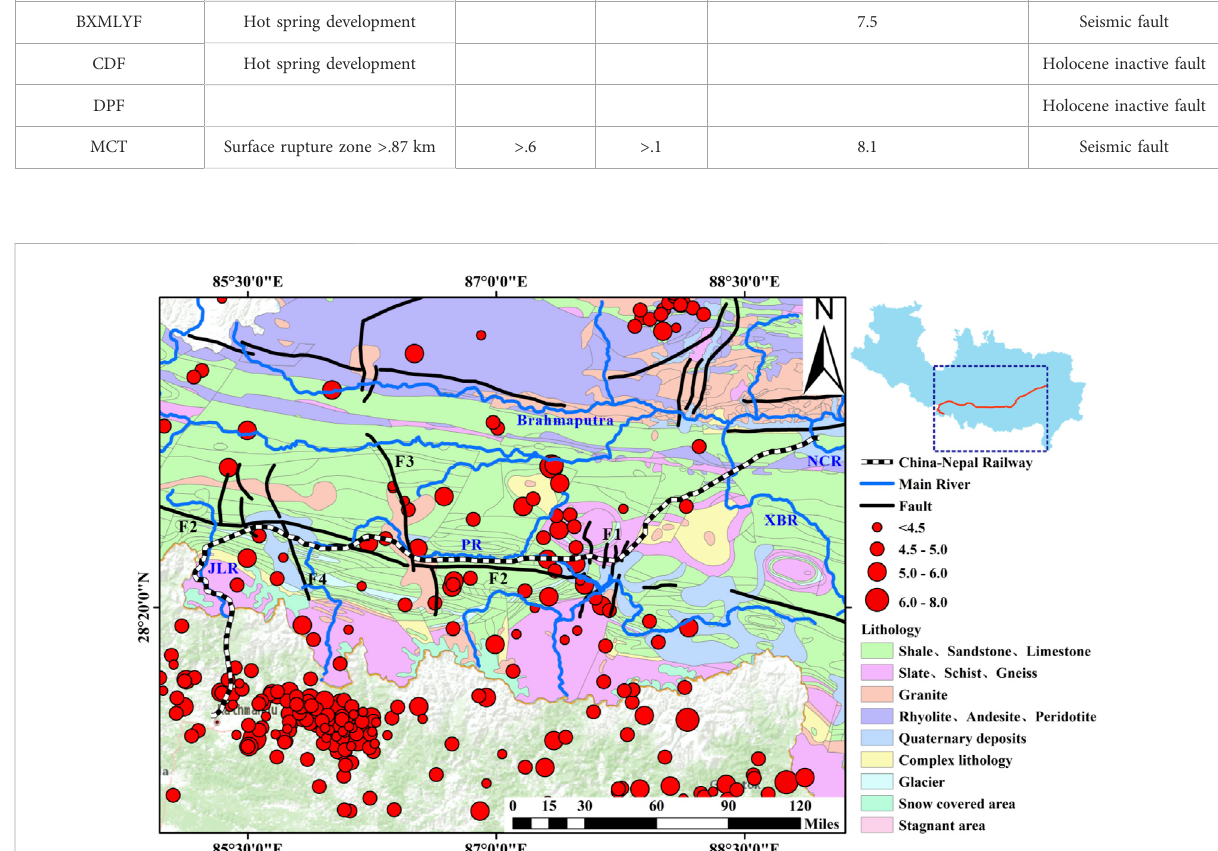
FIGURE 1 Geological map of the study area. F1, JiaGang – DingJie fault; F3, DangReYongCuo – DingRi fault; F4, DingRi fault; JLR, Gyirong River; PR, PengQu River; XBR, XiaBuQu River; NCR, NianChu